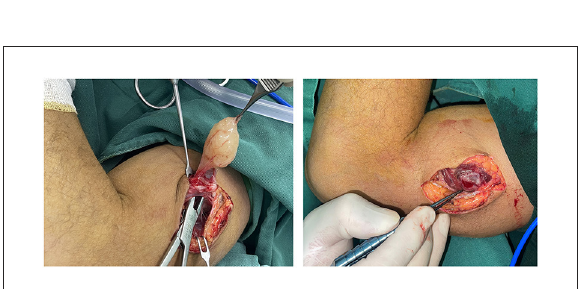
FIGURE9 Radial nerve trunk hemorrhage after tumor shelled